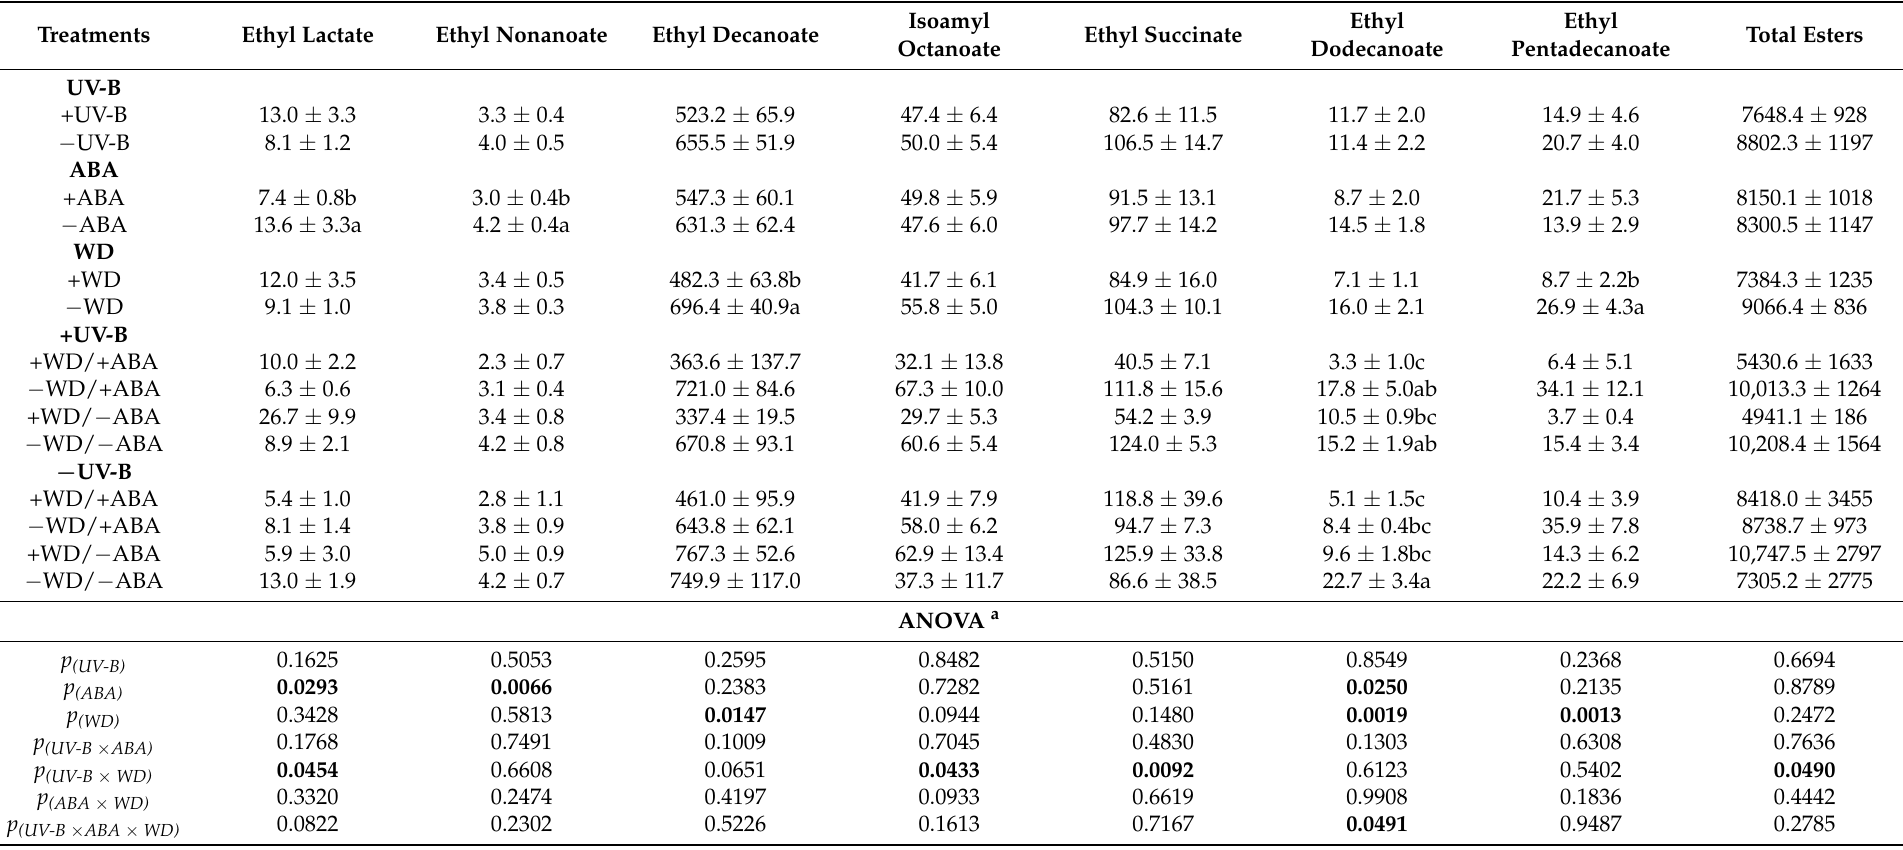
Table 5. Volatile esters ( µ g L − 1 ) determined in wines from Malbec plants exposed to combined UV-B, WD and ABA treatments.